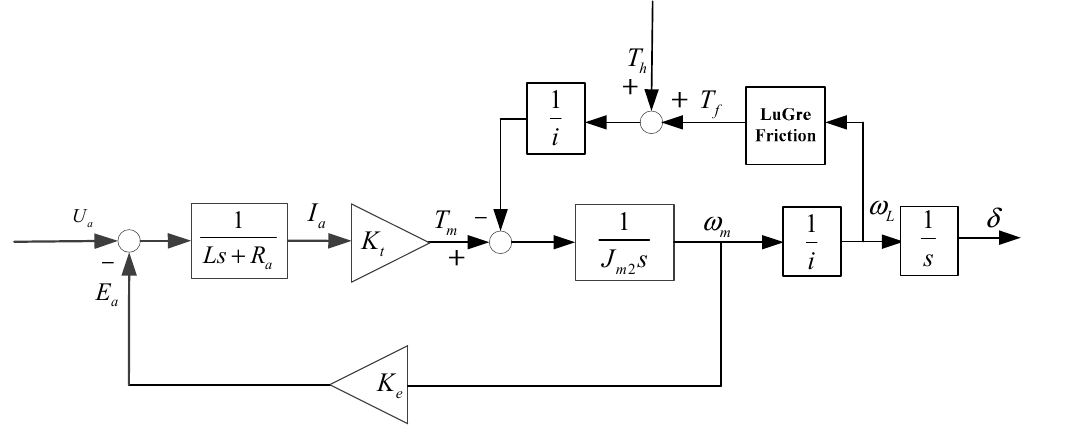
Figure 2. Diagram of simplified EMA model with friction.